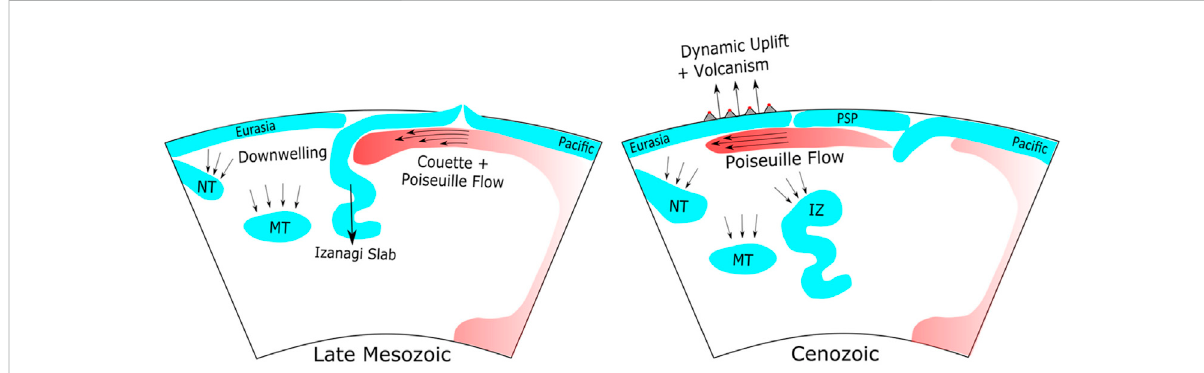
FIGURE 2 Cartoon illustrating the proposed build-up of Paci fi c asthenospheric material in the far western Paci fi c during the late Mesozoic through pressure- and plate-driven fl ow, and subsequent pressure-driven in fl ux into East Asia through the Izanagi-Paci fi c slab window during the Cenozoic. NT, Neotethys slab; MT, Mesotethys slab; IZ, Izanagi slab; PSP, Philippine Sea